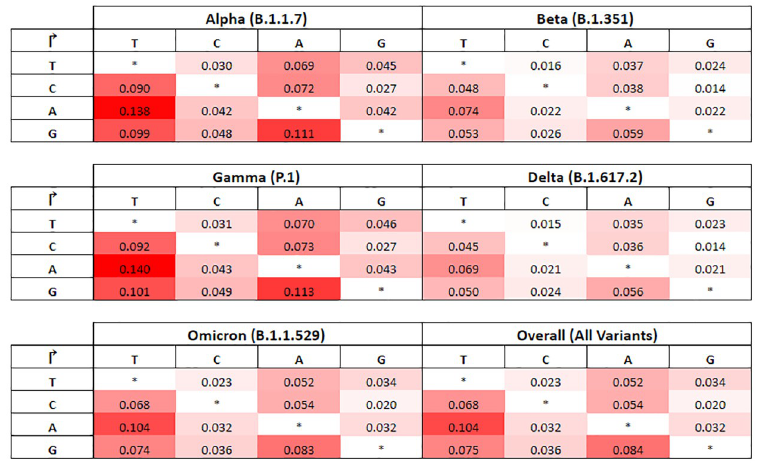
Fig 10. 4x4 mutation rate